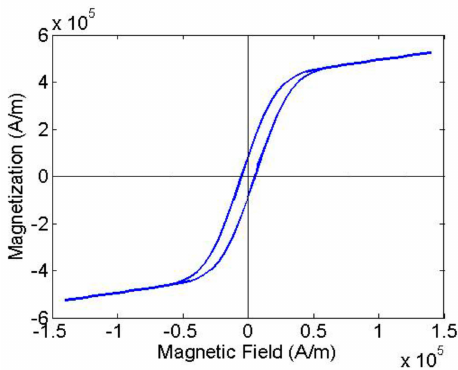
Figure 6. Simulation curve of magnetization and magnetic field